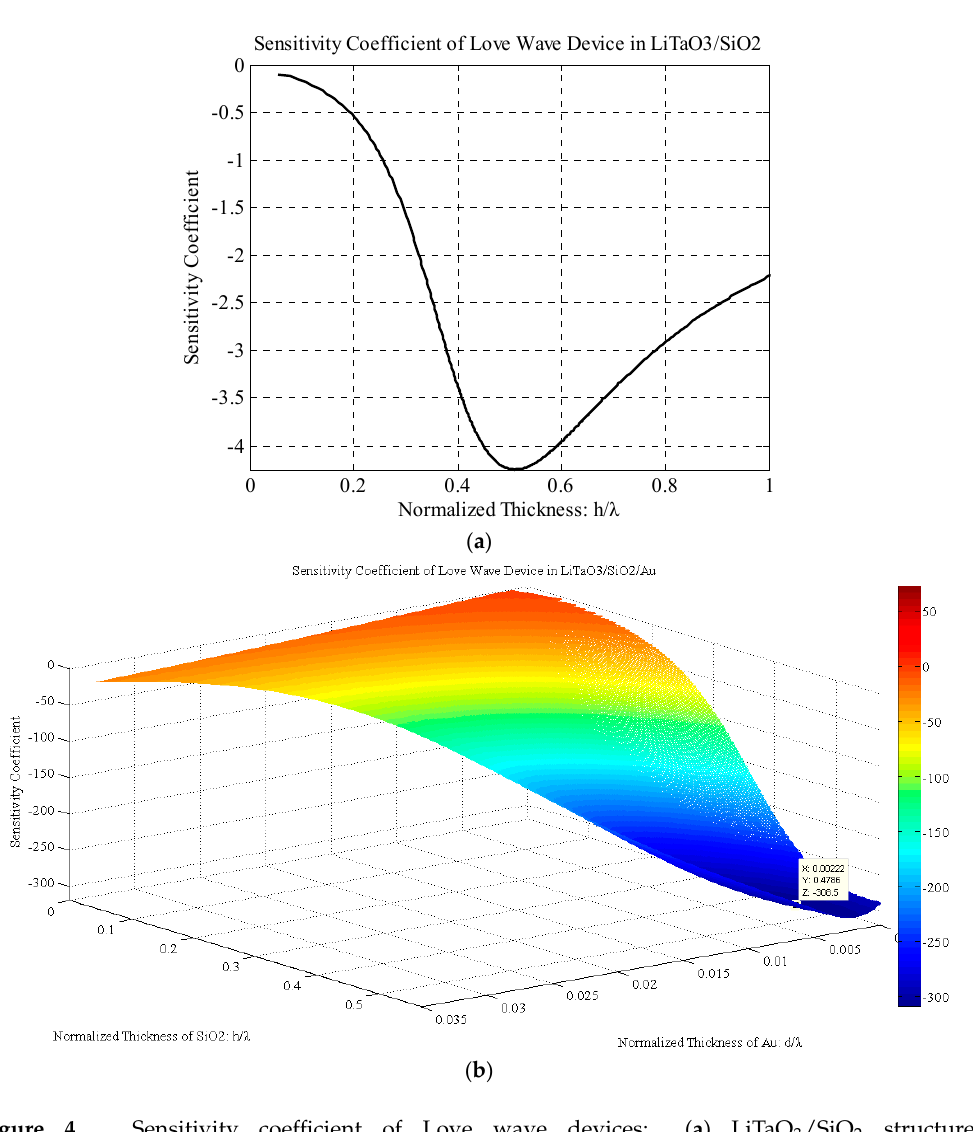
Figure 4. Sensitivity coefficient of Love wave devices: ( a ) LiTaO 3 /SiO 2 structure; ( b ) LiTaO 3 /SiO 2 /Au structure.